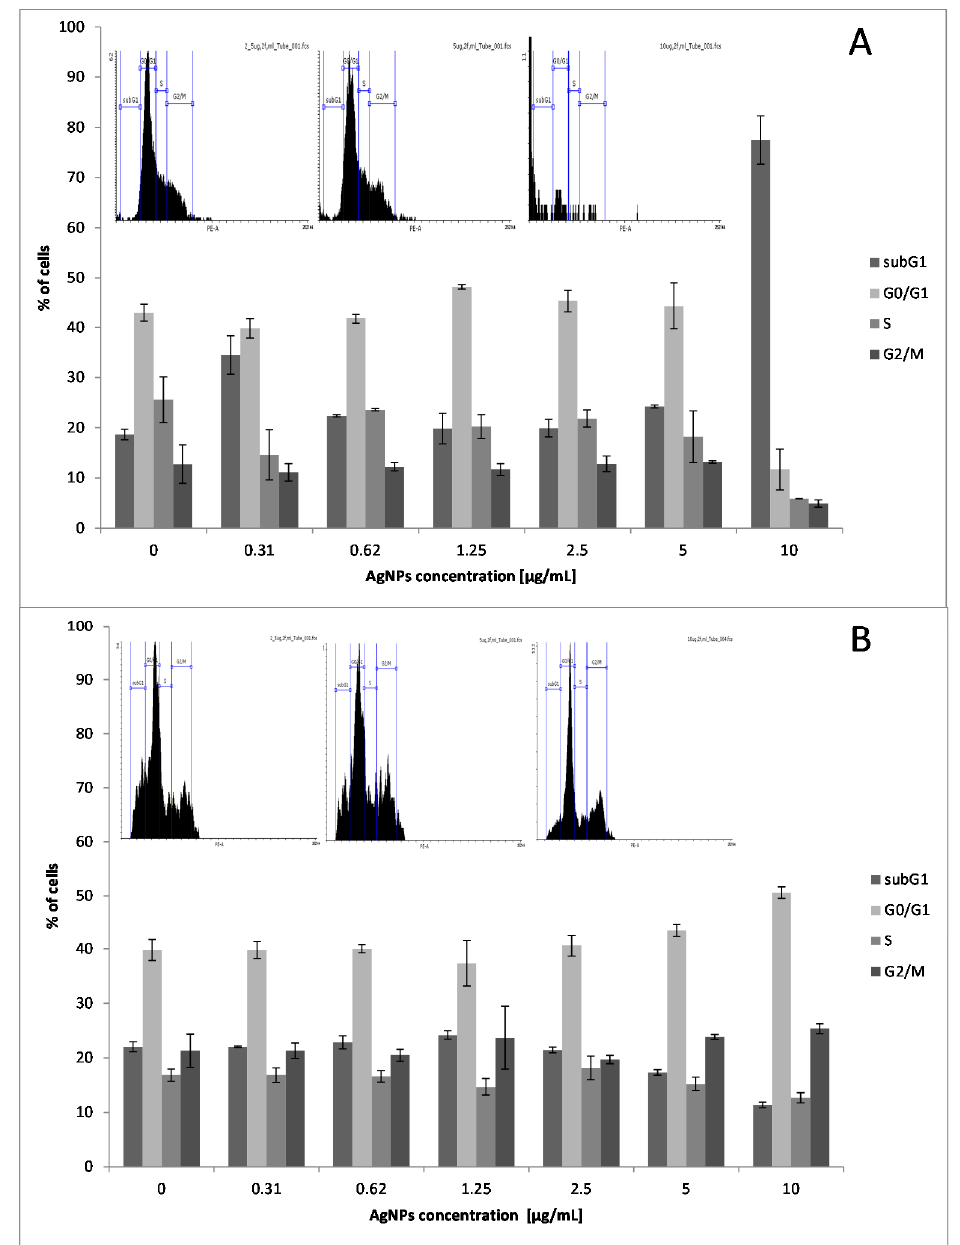
Figure 5. Representative flow cytometric histograms and bar graphs showing the cell cycle distribution when the SCC-25 cells were treated with AgNPs at 0.31, 0.62, 2.5, 5, 10 μ g/mL for 24 h ( A ) and 48 h ( B ). Cells were stained with propidium iodide and subjected to flow cytometric analysis that collected 10,000 events. Alterations in the percentage of SCC-25 cells in subG1, G0/G1, S, and G2/M phases of cell cycle are presented as the mean ± SD of three independent experiments. The results show that AgNPs (10 μ g/mL) has a significant effect on cell cycle arrest, contributing to their anticancer features. AgNPs treatment of SCC-25 with 10 μ g/mL concentration for 24 h and 48 h resulted in a cell cycle (checkpoint) arrest within the subG1 and G0/G1 phase, respectively ( p < 0.01 and p < 0.05, independent experiments).